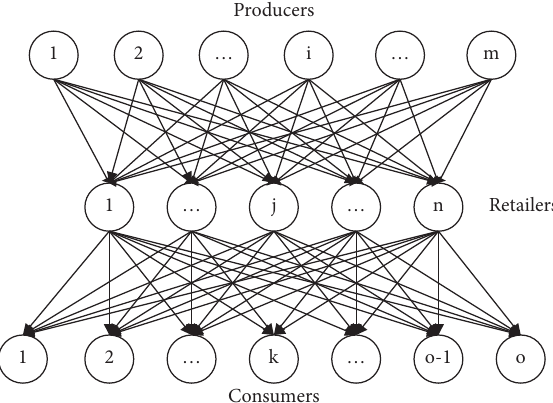
Figure 1: A simplified supply chain network including producers, retailers, and